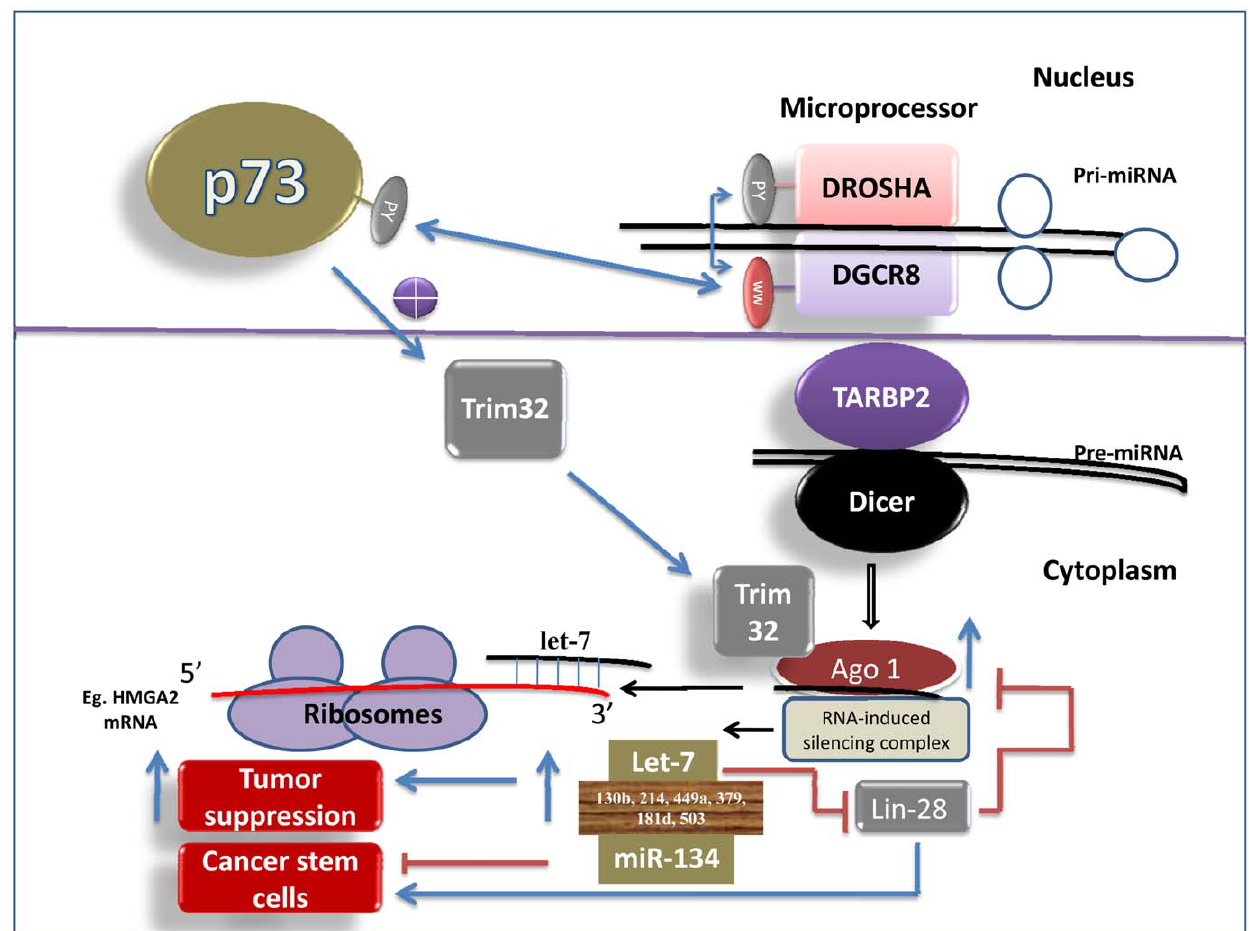
Figure 2. p73 is a regulator of microRNA-processing complex.